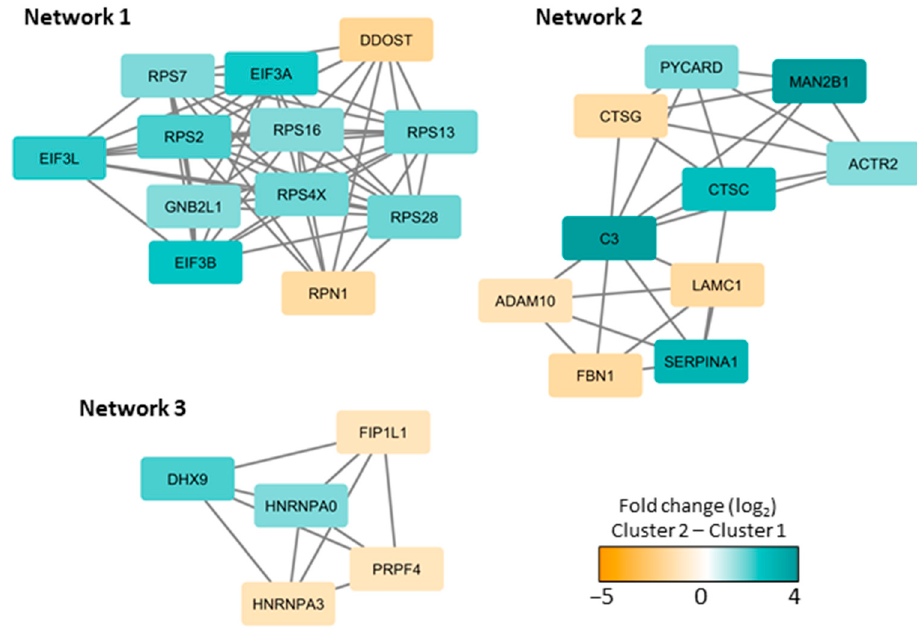
Figure 5. Densely connected protein interaction networks based on the proteins with significantly different protein abundances in cluster 1 (see Figure 4, upper yellow main cluster) and cluster 2 (see Figure 4, lower brown main cluster) in Figure 4. A large protein interaction network was generated in String and imported into Cytoscape to find densely connected proteins using the MCODE application (see Figure S2 for the complete network). The color coding indicates the protein fold change (log 2 transformed) between cluster 2 and 1, where turquoise illustrates increased abundance and orange illustrates decreased abundance in the lower main cluster 2.